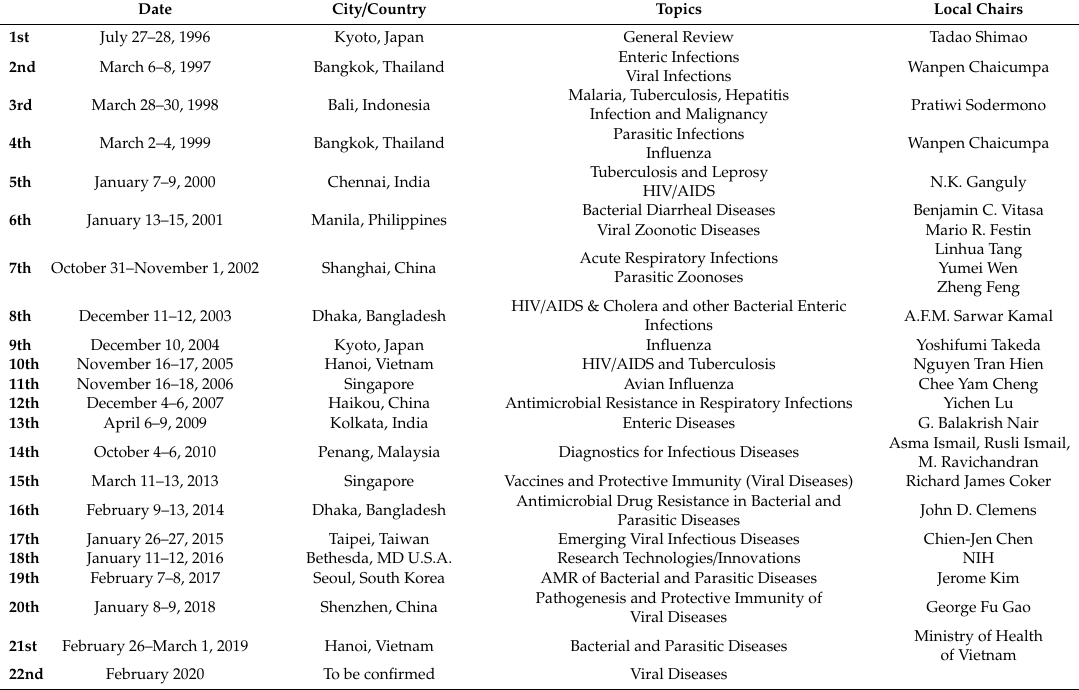
Table 1. Details of the USJCMSP International Conferences on EID in the Pacific Rim City /